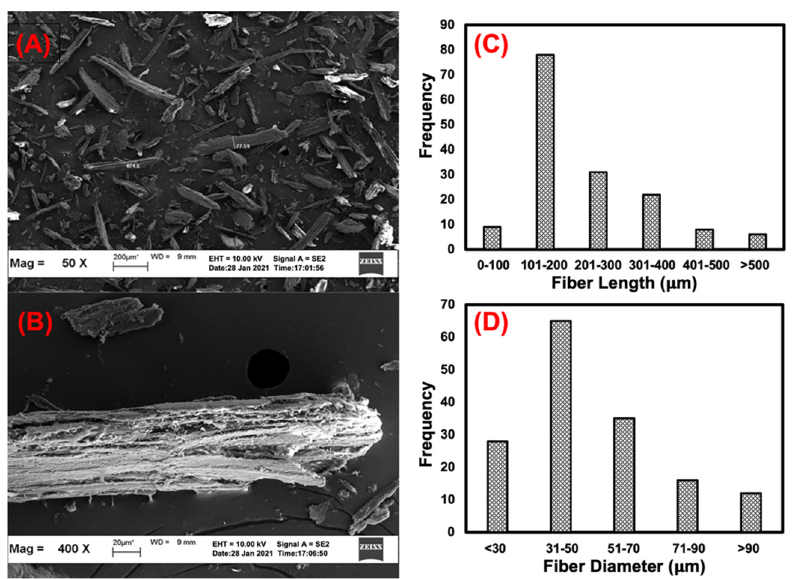
Figure 3. SEM images of KP ( A , B ) and its fibre length and fibre diameter distribution ( C , D ).